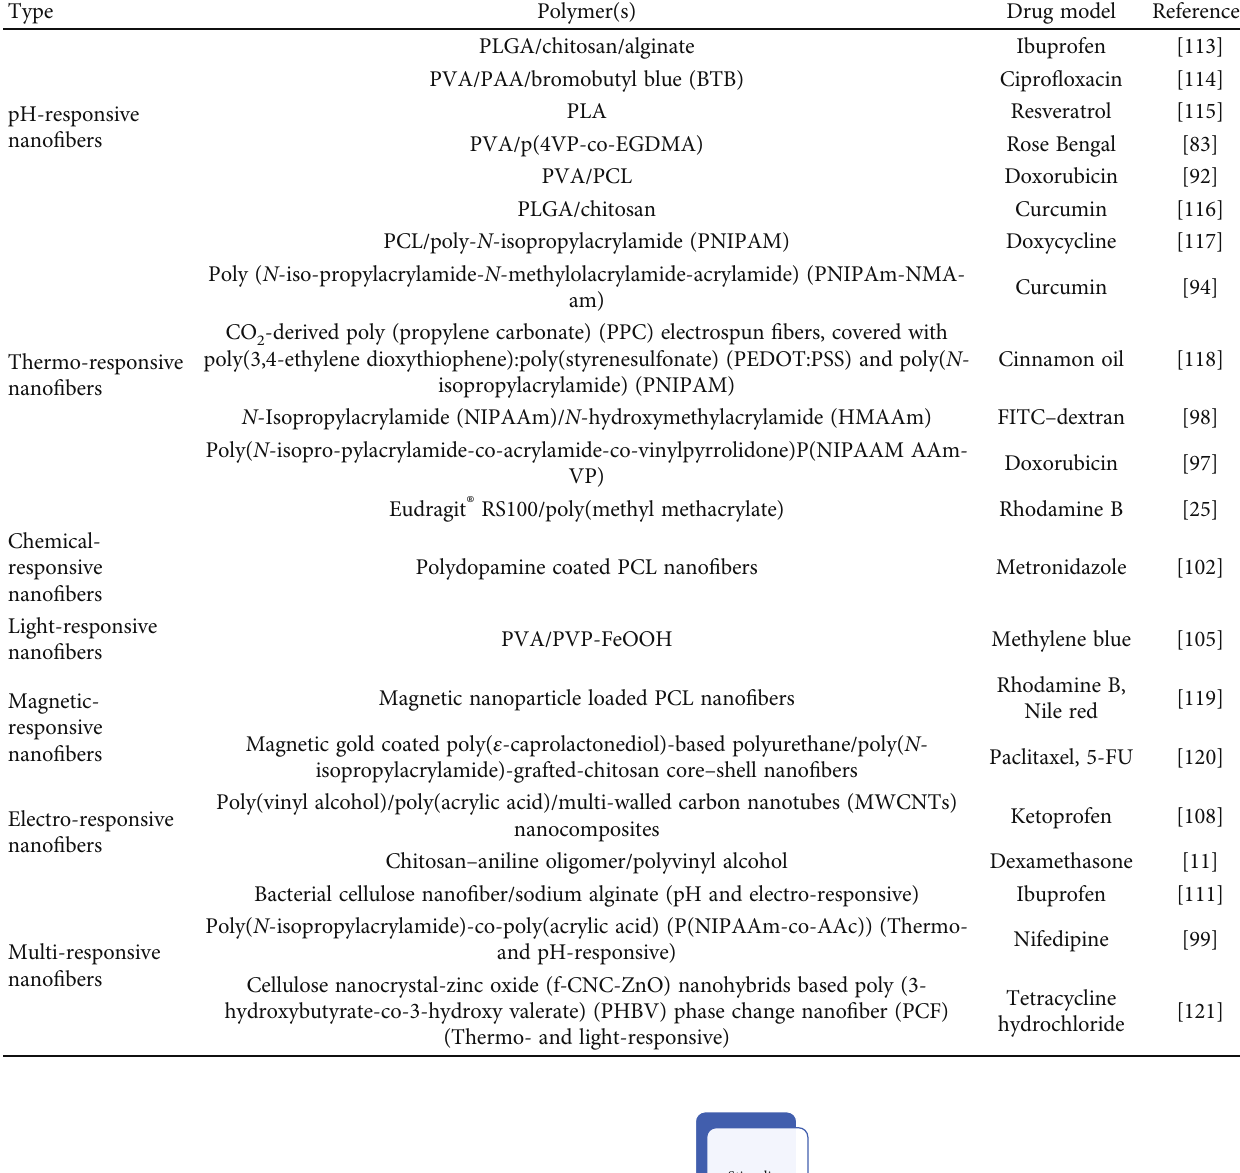
Table 2: Example of di ff erent types of stimuli-responsive fi bers.